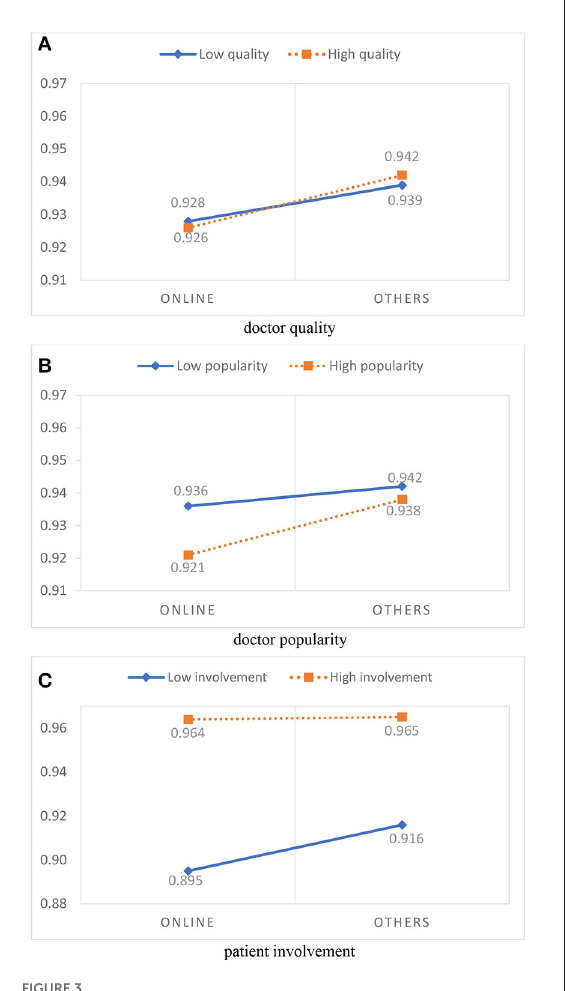
FIGURE3 Moderation effects of online health information sources on treatment effect satisfaction. (A) Doctor quality. (B) Doctor popularity. (C) Patient